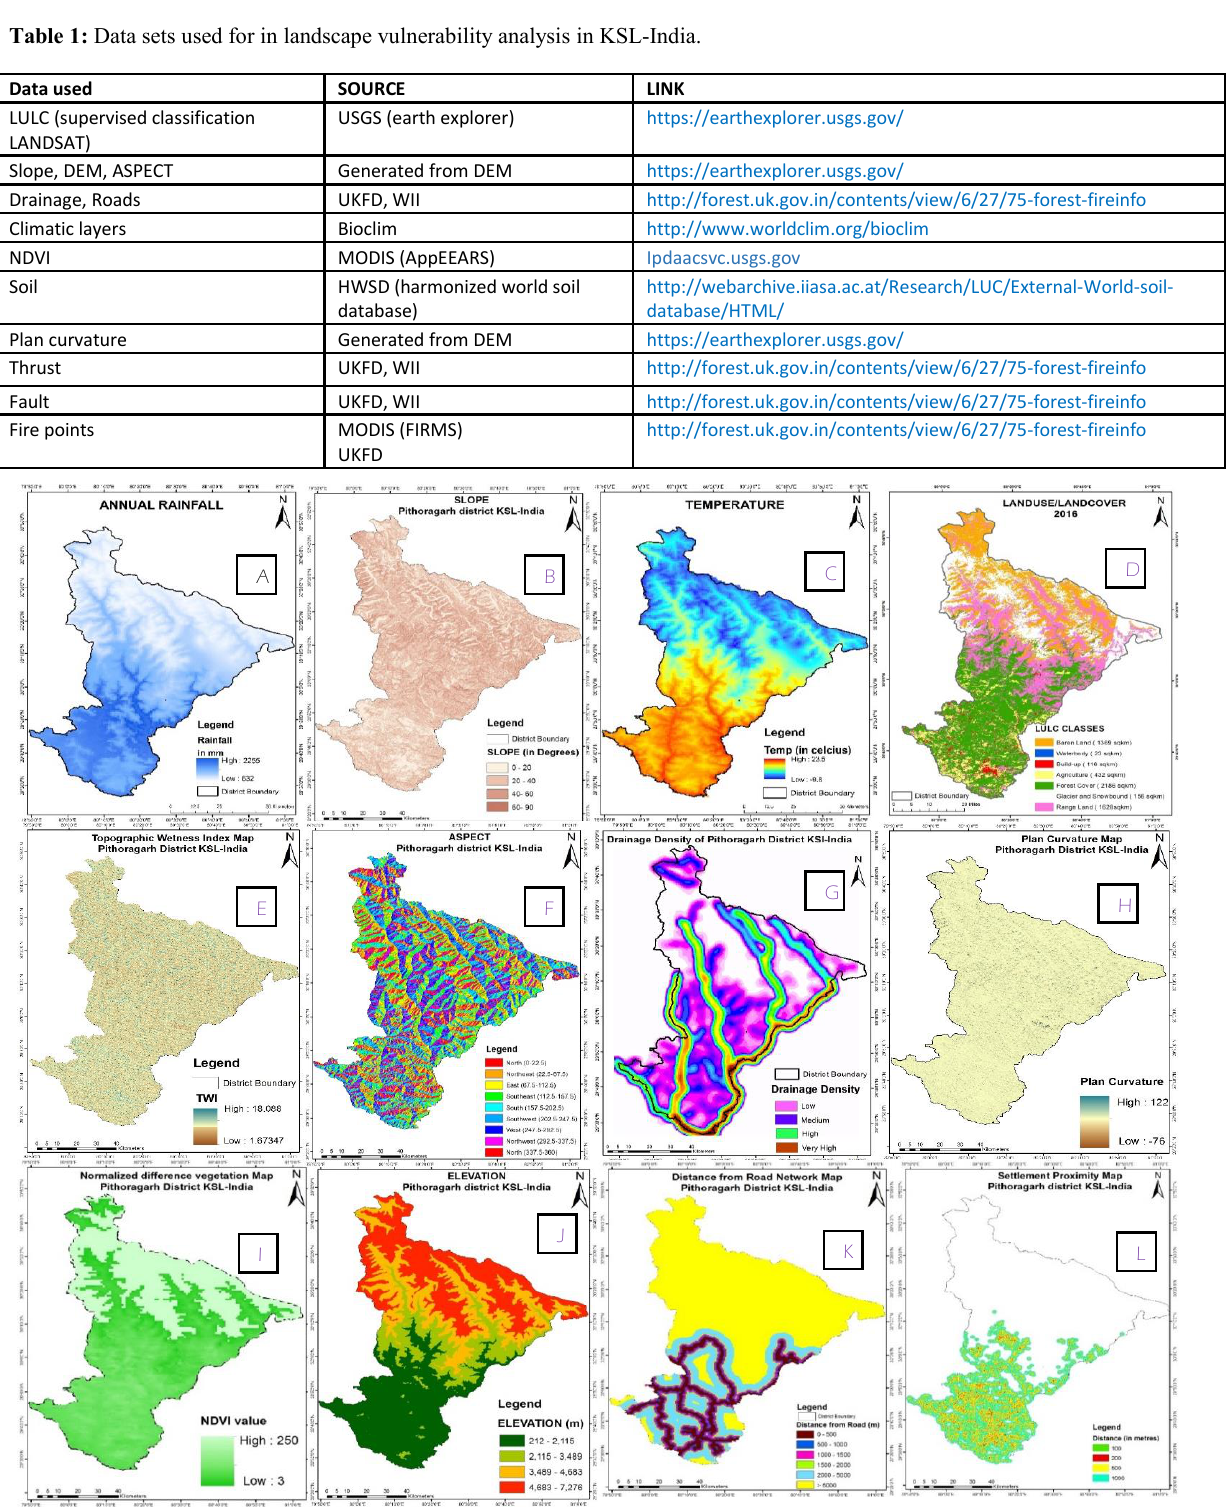
Fig 3: Parameters used for landscape vulnerability analysis through AHP are: (a) annual rain fall, (b) degree of slope, (c) temperature, (d) LULC, (e) Topographic Wetness Index, (f) aspect, (g) drainage density, (h) plan curvature, (I) NDVI, (j) elevation, (k) distance to road, (l) proximity to